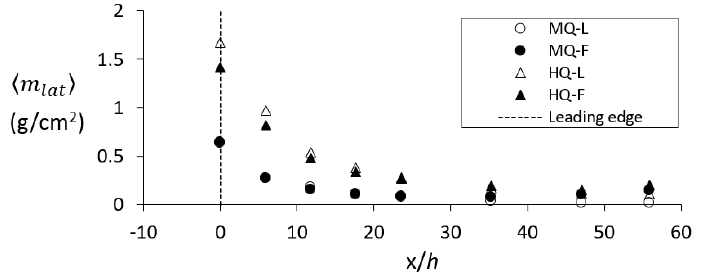
Figure 11. Laterally averaged net deposition (cid:104) m lat (cid:105) in g / cm 2 over the streamwise direction, showing the longitudinal pattern of net deposition in the vegetated area. MQ = medium flow rate (50 L / s); HQ = high flow rate (83 L / s); L = leafless; F = foliated. consisting of leafless (L) and foliated flexible plants (F) under medium (MQ) and high flow rates (HQ).